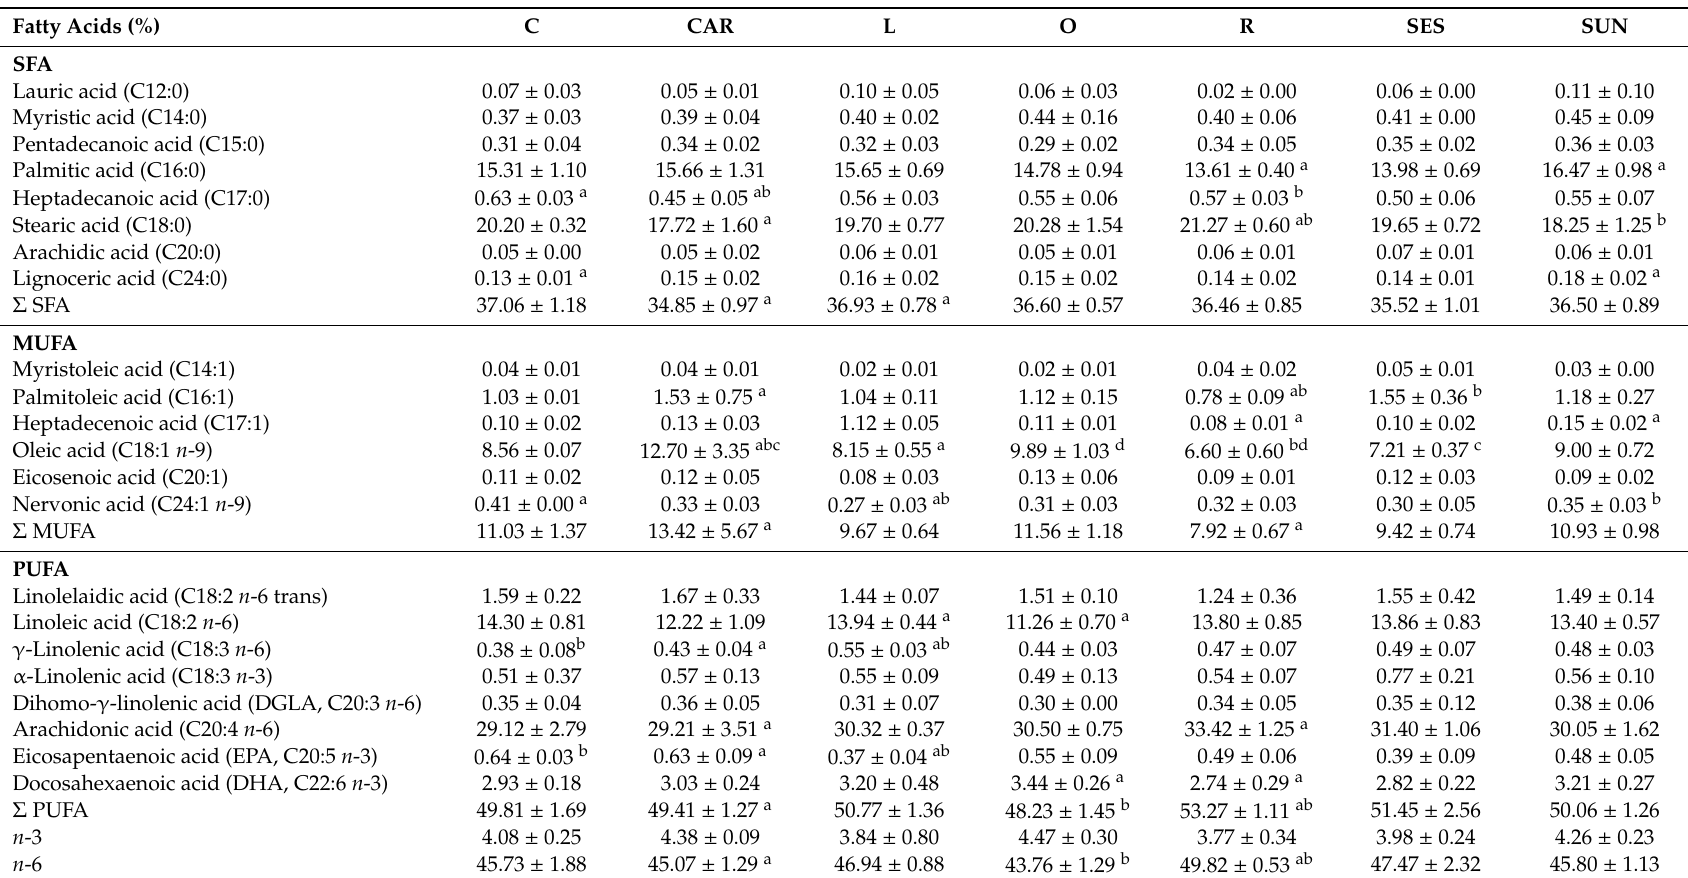
Table 3. Fatty acid composition in serum of rats supplemented with selected oils